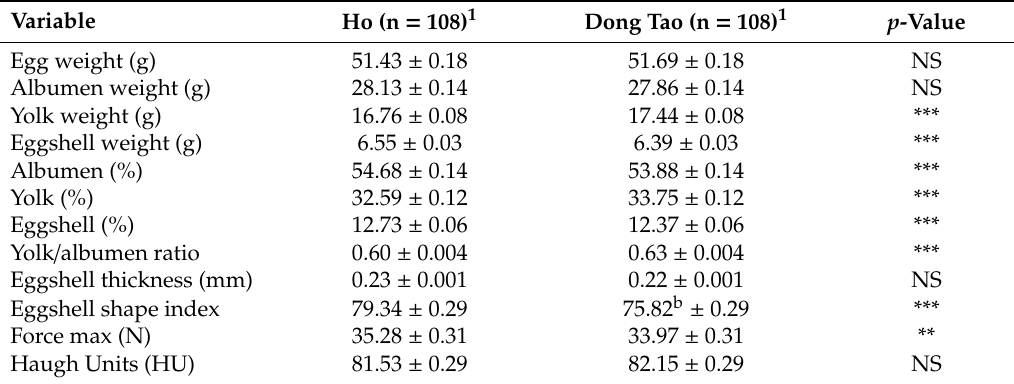
Table 8. Egg quality of Ho and Dong Tao chicken (LSM ±